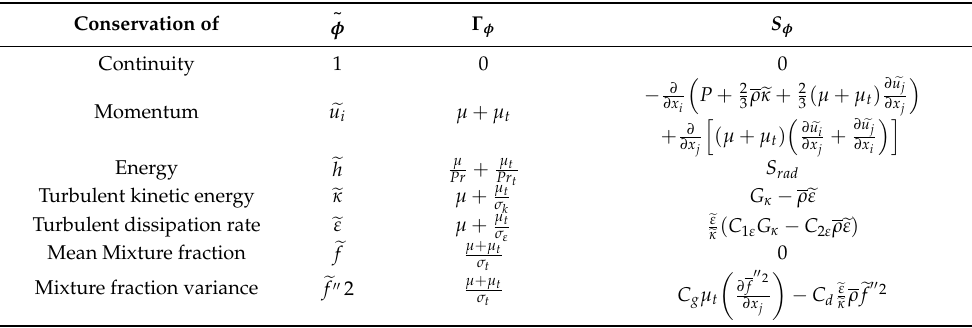
Table 1. Scalar, diffusion coefficient, and source term for the governing equation. Conservation